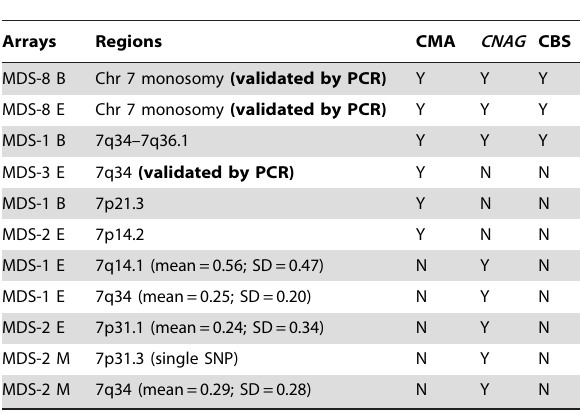
Table 6. Comparison of selected abnormal regions in chromosome 7 by CMA algorithm, CNAG and CBS. Y and N denote if the region is selected or not, respectively.